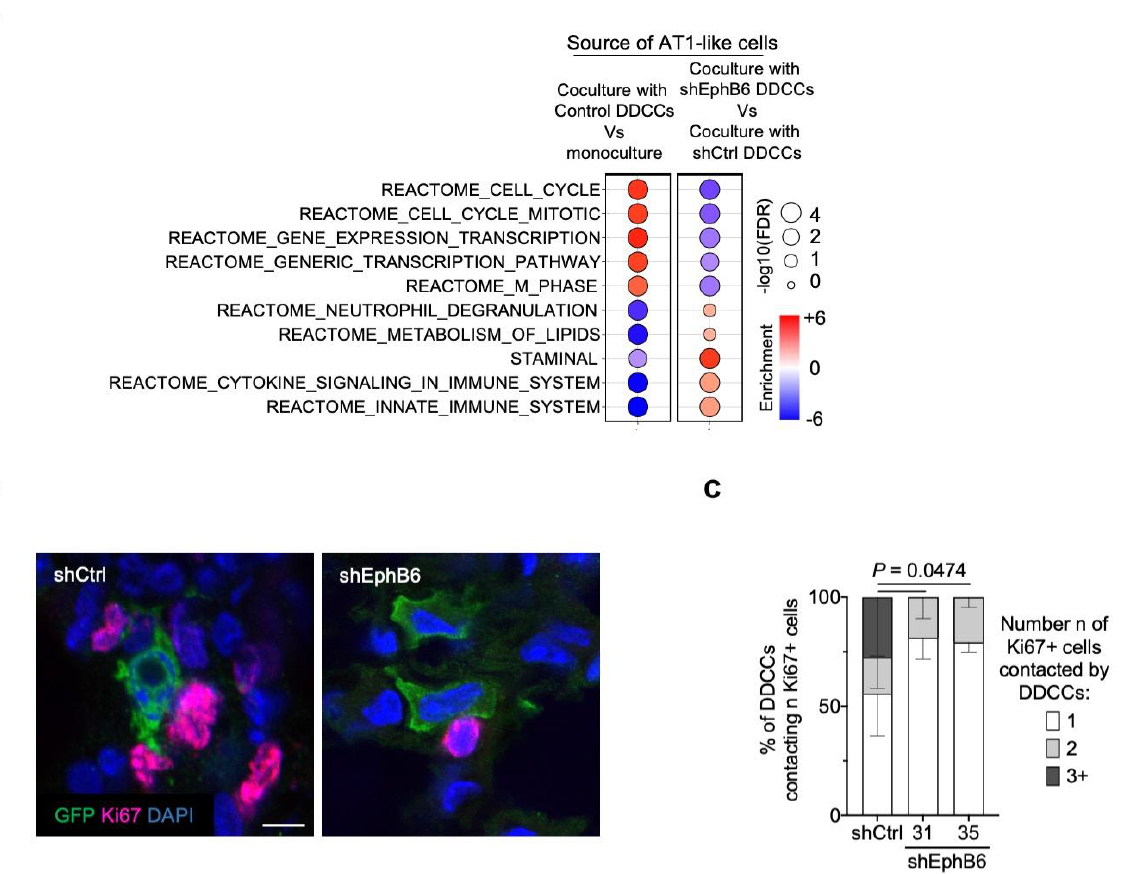
Figure 3. EphB6 regulates the crosstalk with lung epithelial cells. ( A ) Balloon plot summarizing GSEA results of AT1-like cells in monoculture and cocultured with D2.0R-EGFP-shCtrl cells or shEphB6 cells (results from two independent shEphB6 sequences, #31 and #35). Balloon size represents the statistical significance ( − log 10 FDR), while color indicates the fold-enrichment for each term (NES). Complete the list of gene sets in Figure S1. ( B ) Representative images of Ki67+ lung resident cells surrounding GFP+ disseminated indolent breast cancer cells with control shRNA or shRNAs targeting EphB6. Scale bar, 10 µ m. ( C ) Quantification of images in B. Percentage of D2.0R-EGFP cells in contact with the indicated number of Ki67+ lung cells. n = 191, 143 and 177 cells for shCtrl, shEphB6#31 and shEphB6#35, respectively, across 3 mice/sample. P-value of the percentage of D2.0R-EGFP cells contacting 3 Ki67+ lung cells. 2 way ANOVA, multiple